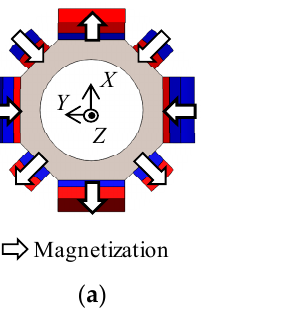
Figure 3. Magnetic flux path. ( a ) Mover; ( b ) magnetic flux path of the outer Yoke A and the mover; ( c ) magnetic flux path of the outer Yoke B and the mover.